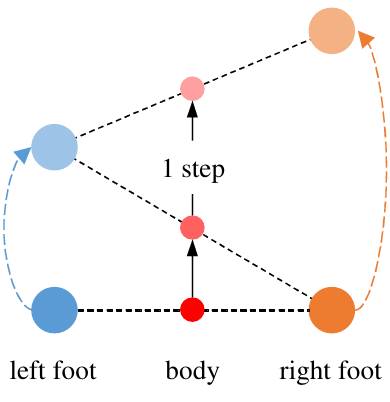
Figure 5. Definition of one